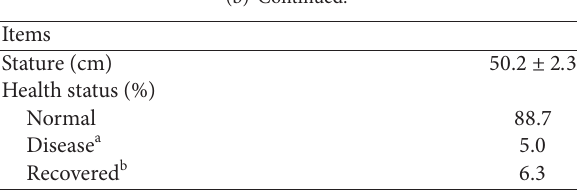
Table 1: Characteristics of